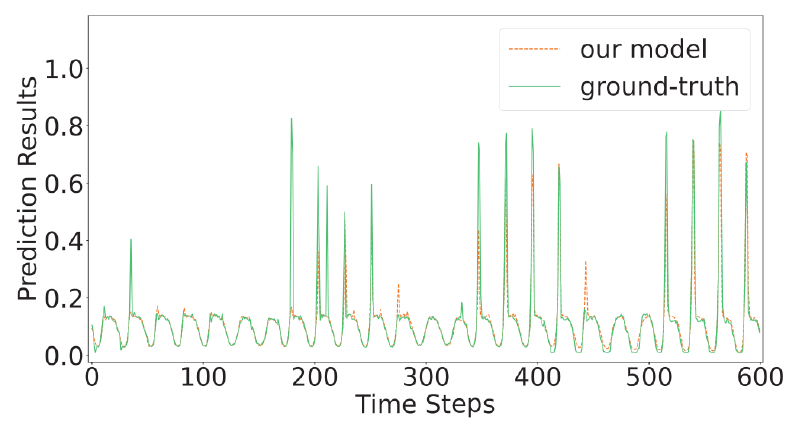
Figure 11. Traffic (Horizon = 24) forecast